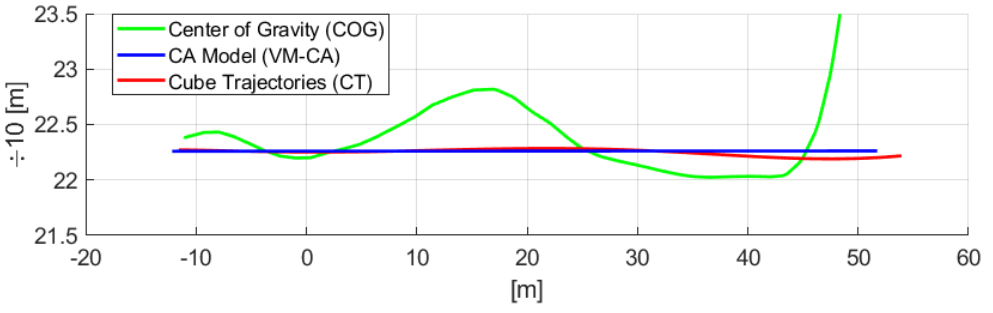
Figure 13. Trajectory solutions for the three methods.